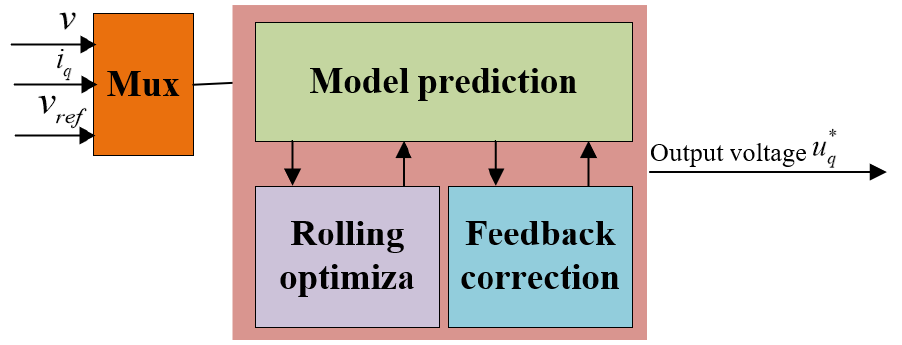
Figure 2. MPC system.